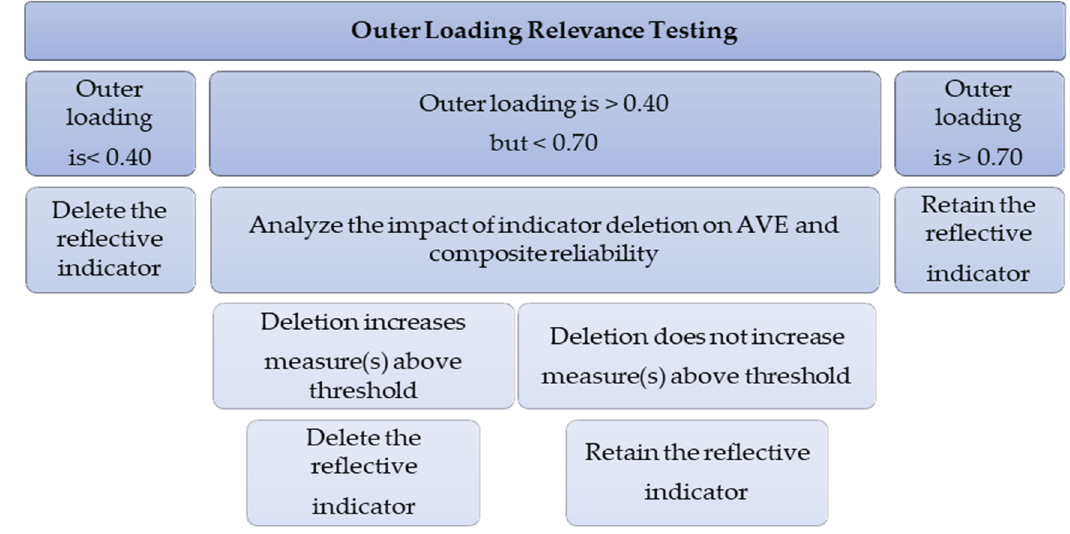
Figure 6. The Testing of Outer Loading Relevance. Figure 6. The testing of outer loading relevance.